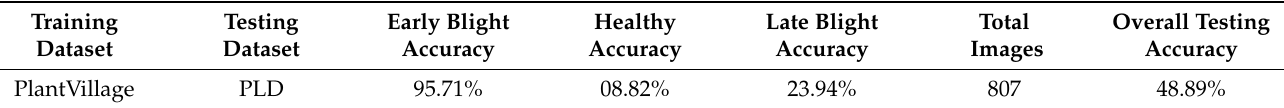
Table 3. Classification Accuracies of the proposed PDDCNN model training on PlantVillage and testing on the PLD dataset.